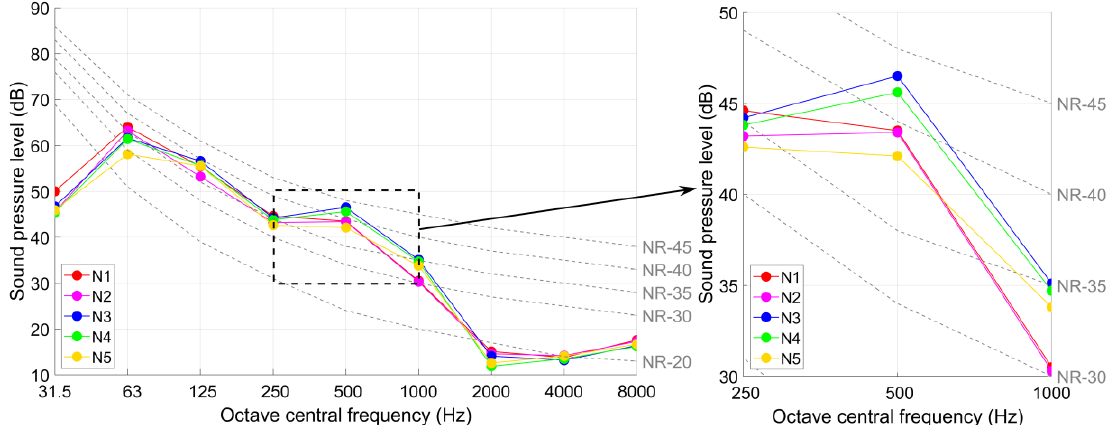
Figure 23. NR curves in the noise test points in the cinema.